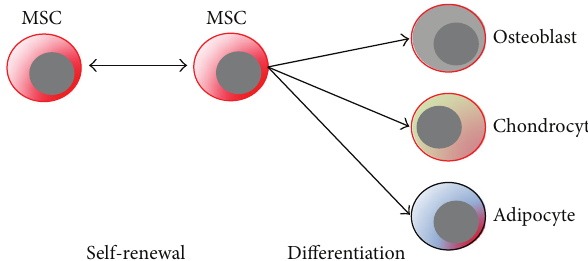
Figure 1: Overview on self-renewal or differentiation of stem cells in their respective stem cell